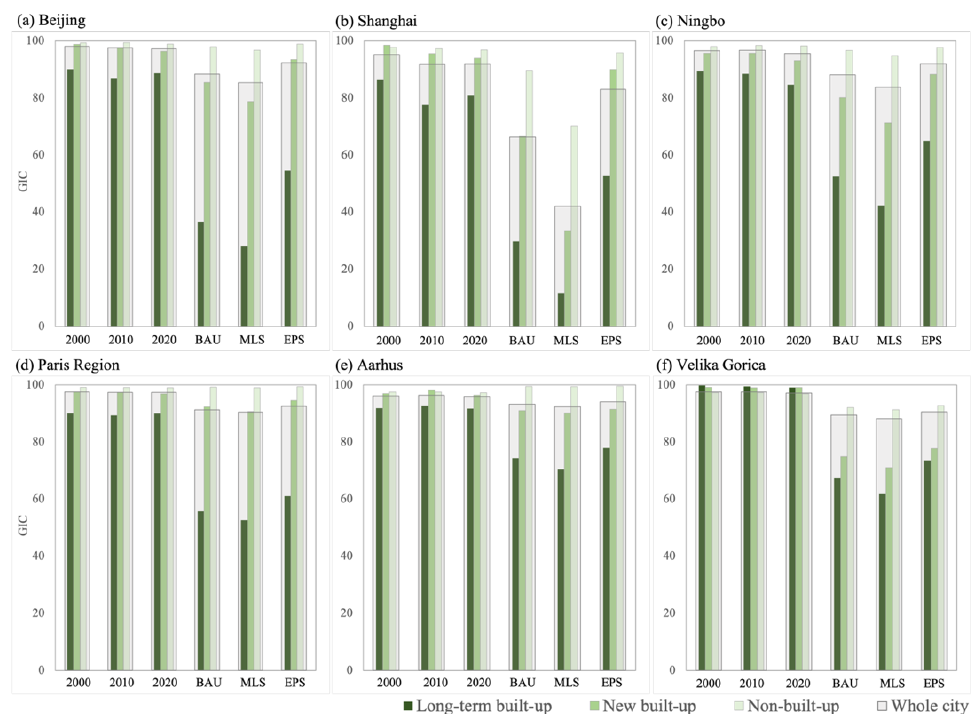
Figure A2. Land-cover transfer between 2020 and 2030 for various categories under different sce- narios.